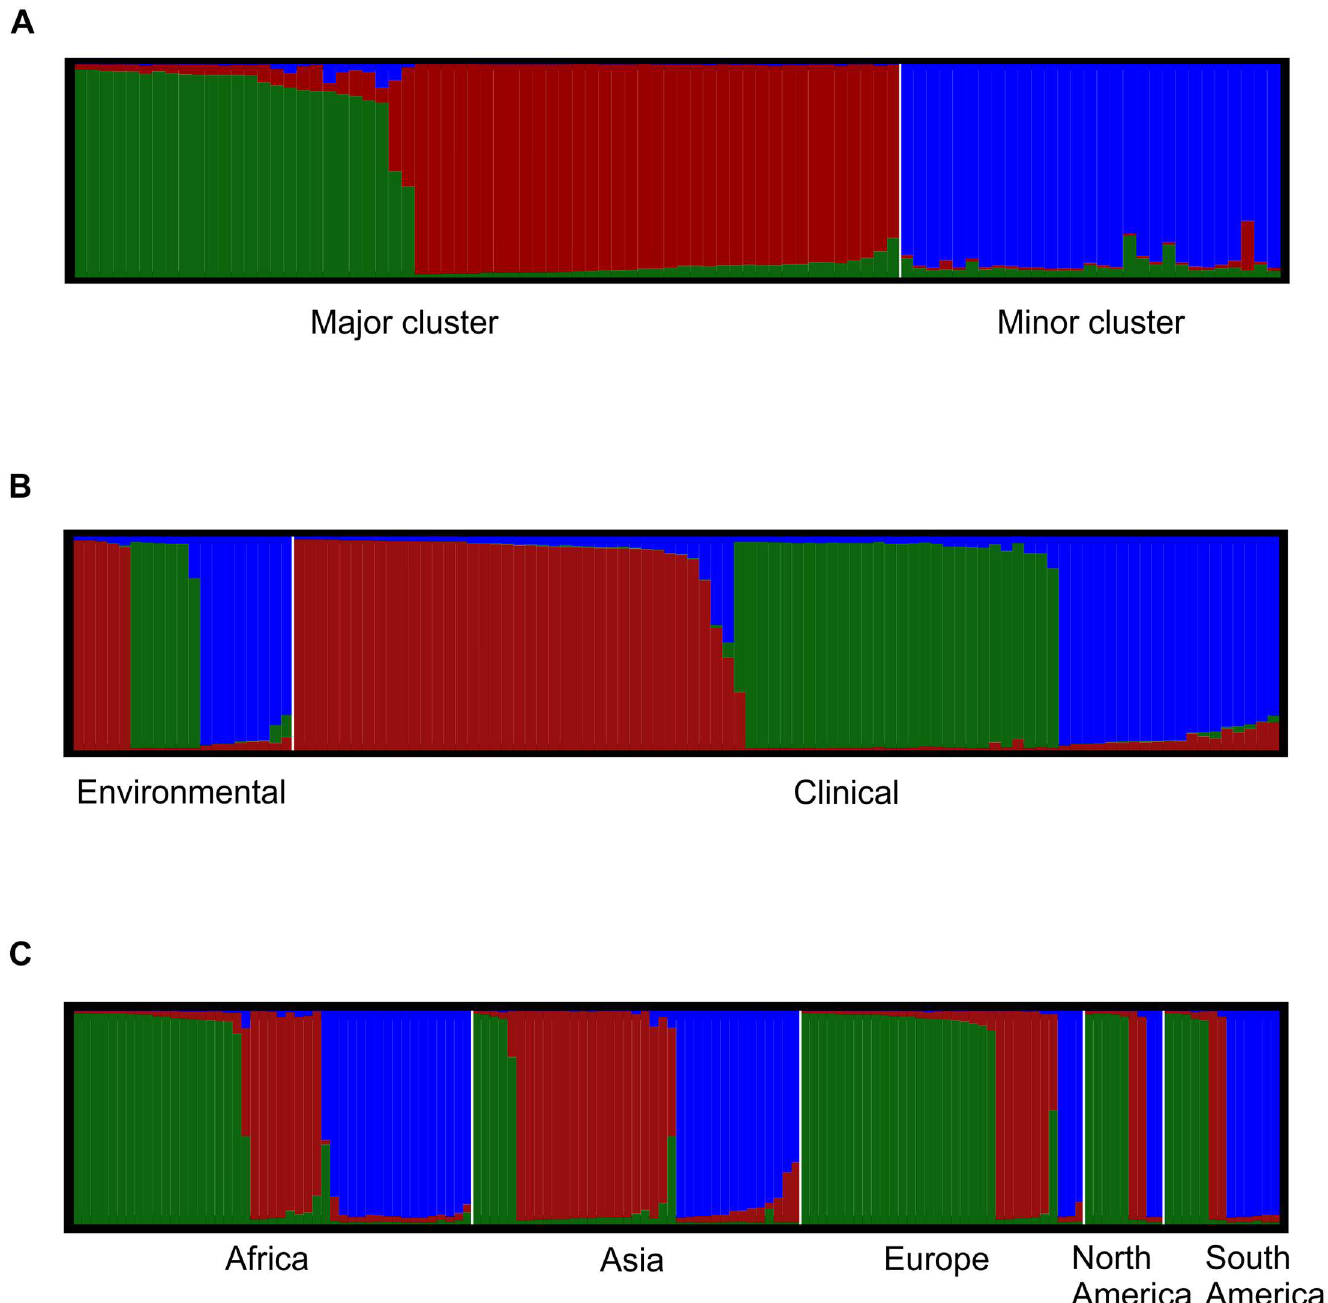
Fig 5. Structure analysesof Cryptococcus neoformans var. grubii VNI showing that K = 3 is the actual number of subpopulations. Clusters of individuals based on prior-defined populations according to: A) major and minor main clusters identified in the phylogenetic and coalescence analysesusing the expanded global dataset (92 isolates), B) clinical and environmental isolates (104 isolates), and C) according to continents (136 isolates). Each vertical line represents one ST and the colours represent the most likely ancestry of each individual from the population. Individuals with multiplecolours have admixedgenotypesfrom the prior-defined subpopulations. One ST per regionand/or per pre-defined subpopulation was used throughout the